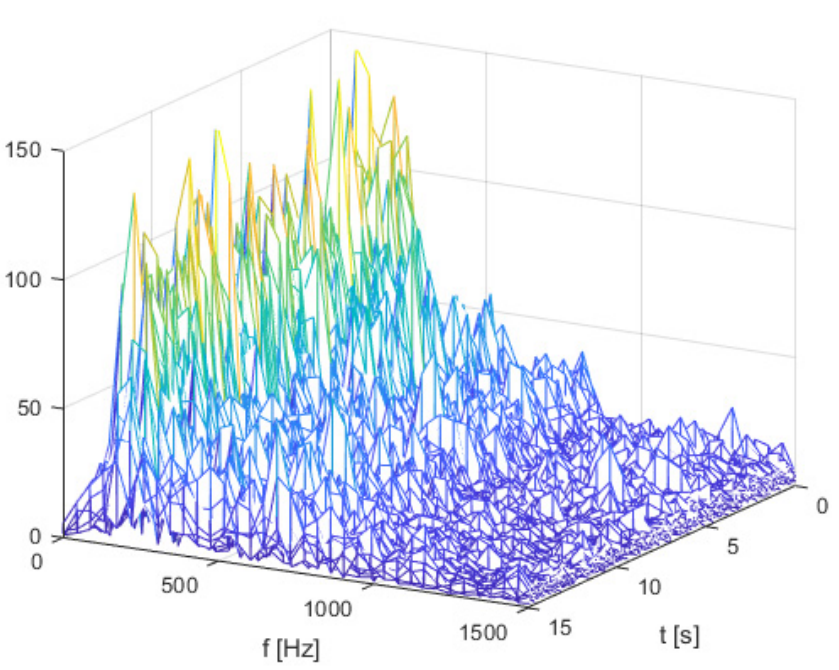
Figure 9. Three-dimensional graph STFT for coal.